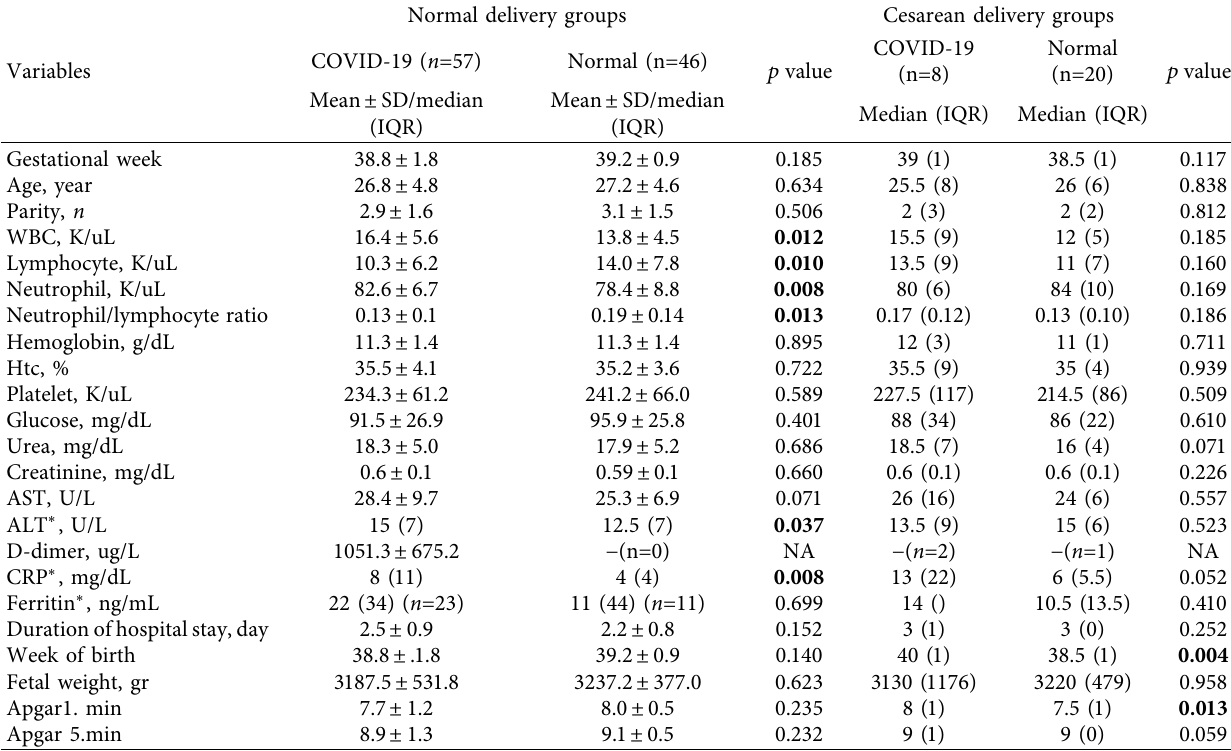
Table 2: Comparison of biochemical variables between COVID-19 and normal pregnant groups in normal and cesarean delivery.